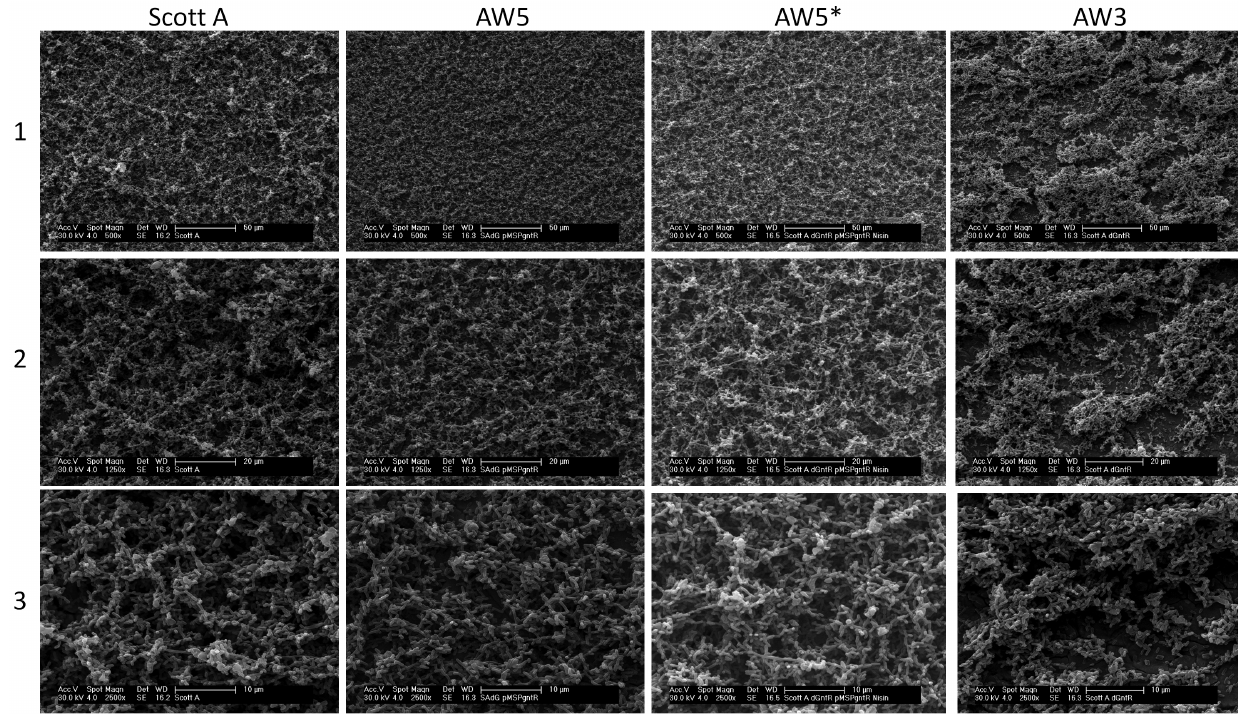
Figure 2. Scanning electron microscopy of Listeriamonocytogenes biofilms. Listeria monocytogenes strains include Scott A, AW5 without nisin (AW5), and AW5 induced with nisin (AW5*), AW3. Magnifications are 500x (1), 1250x (2), and 2500x (3).